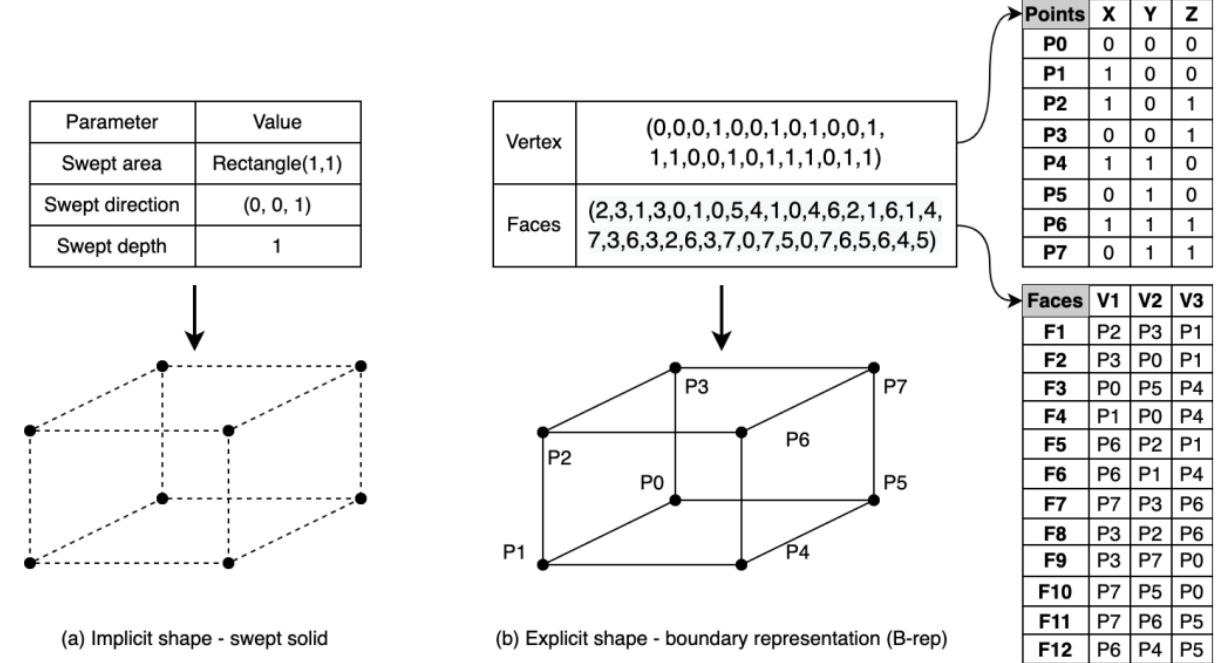
Figure 18. Examples of ( a ) implicit model and ( b ) explicit model.